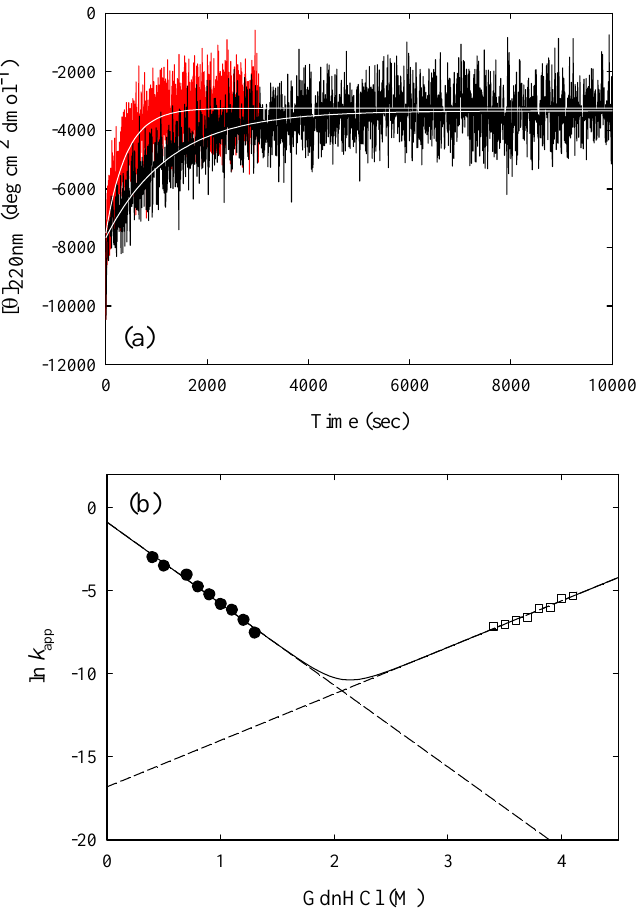
Figure 6. (a) Representative kinetic unfolding curves for Tk-RNase HII at 50 °C , monitored by a change in CD at 220nm. The reaction was initiated by GdnHCl concentration jumps to 3.9M (red line) and 3.4M (black line). Unfolding curves are fit to a single exponential. (b) GdnHCl concentration dependence of the apparent rate constants ) of the unfolding (open squares) and refolding (closed circles) kinetics of Tk-RNase ( k app HII at 50 °C. The solid line represents the theoretical curve using Equation (3). Figures are reproduced from [20].